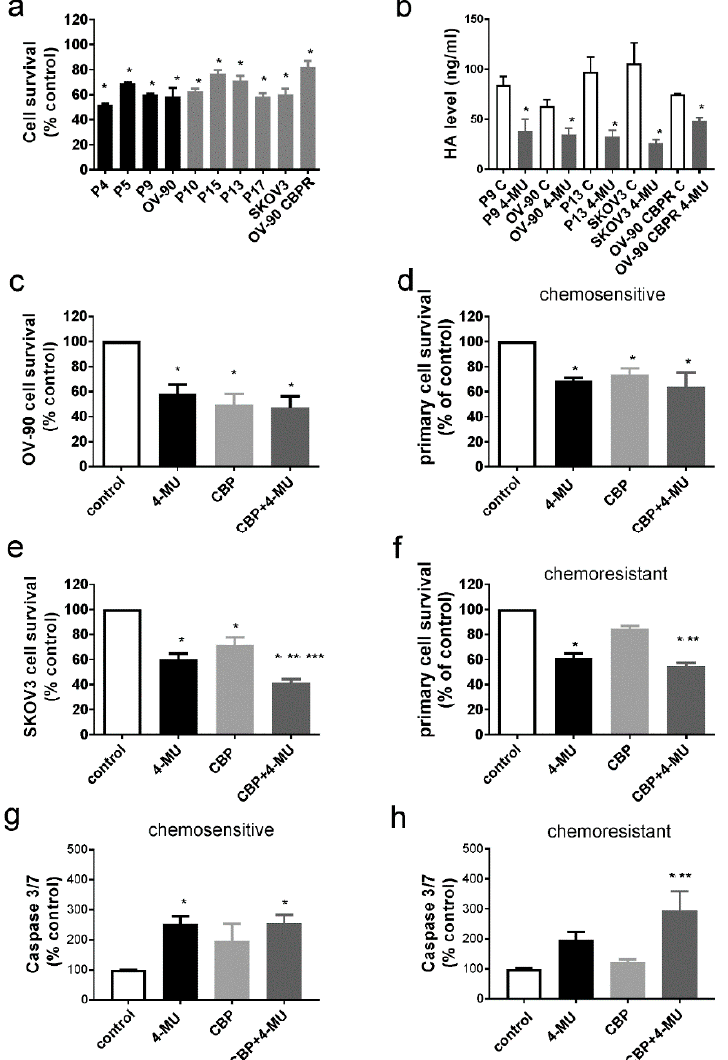
Figure 3. E ff ects of 4-methylubelliferone (4-MU) and carboplatin on ovarian cancer cell survival